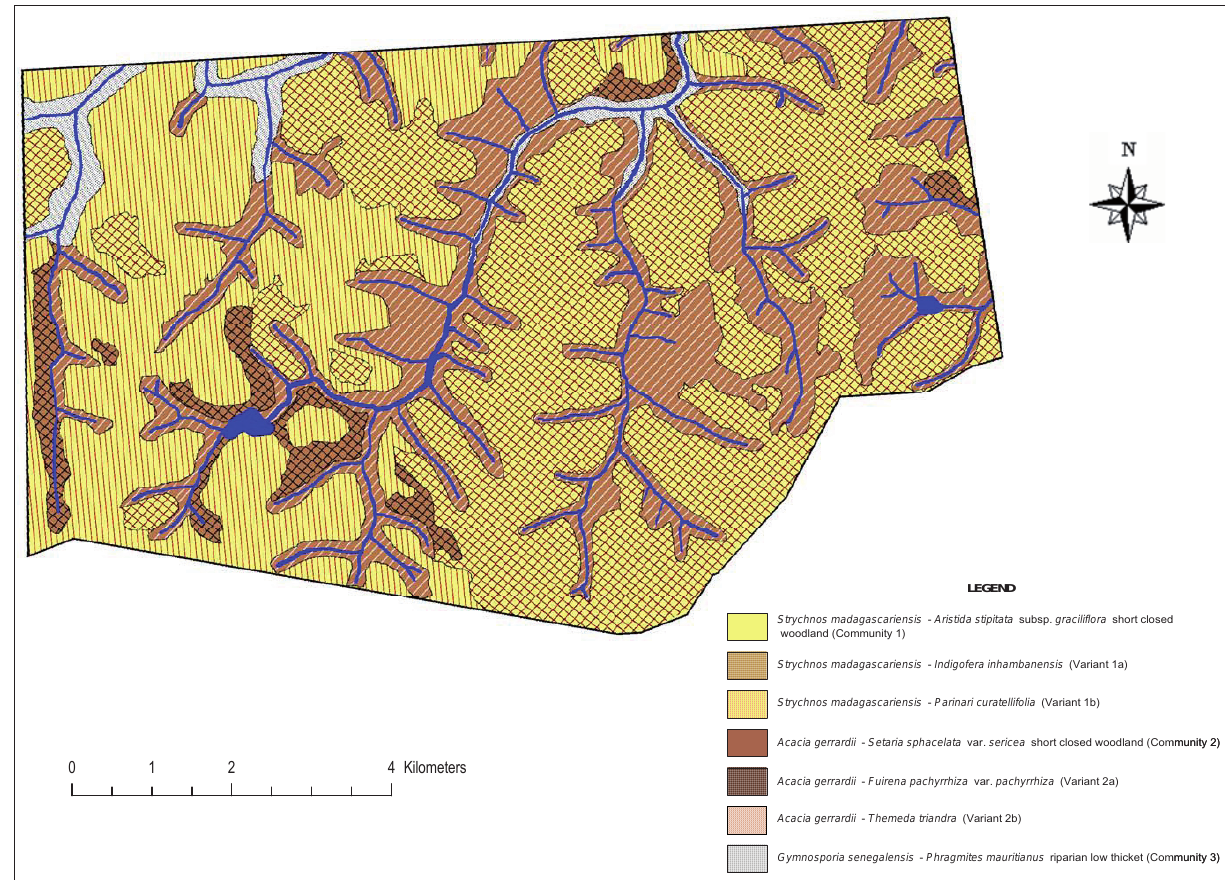
Figure 1 Plant communities of the Andover Game